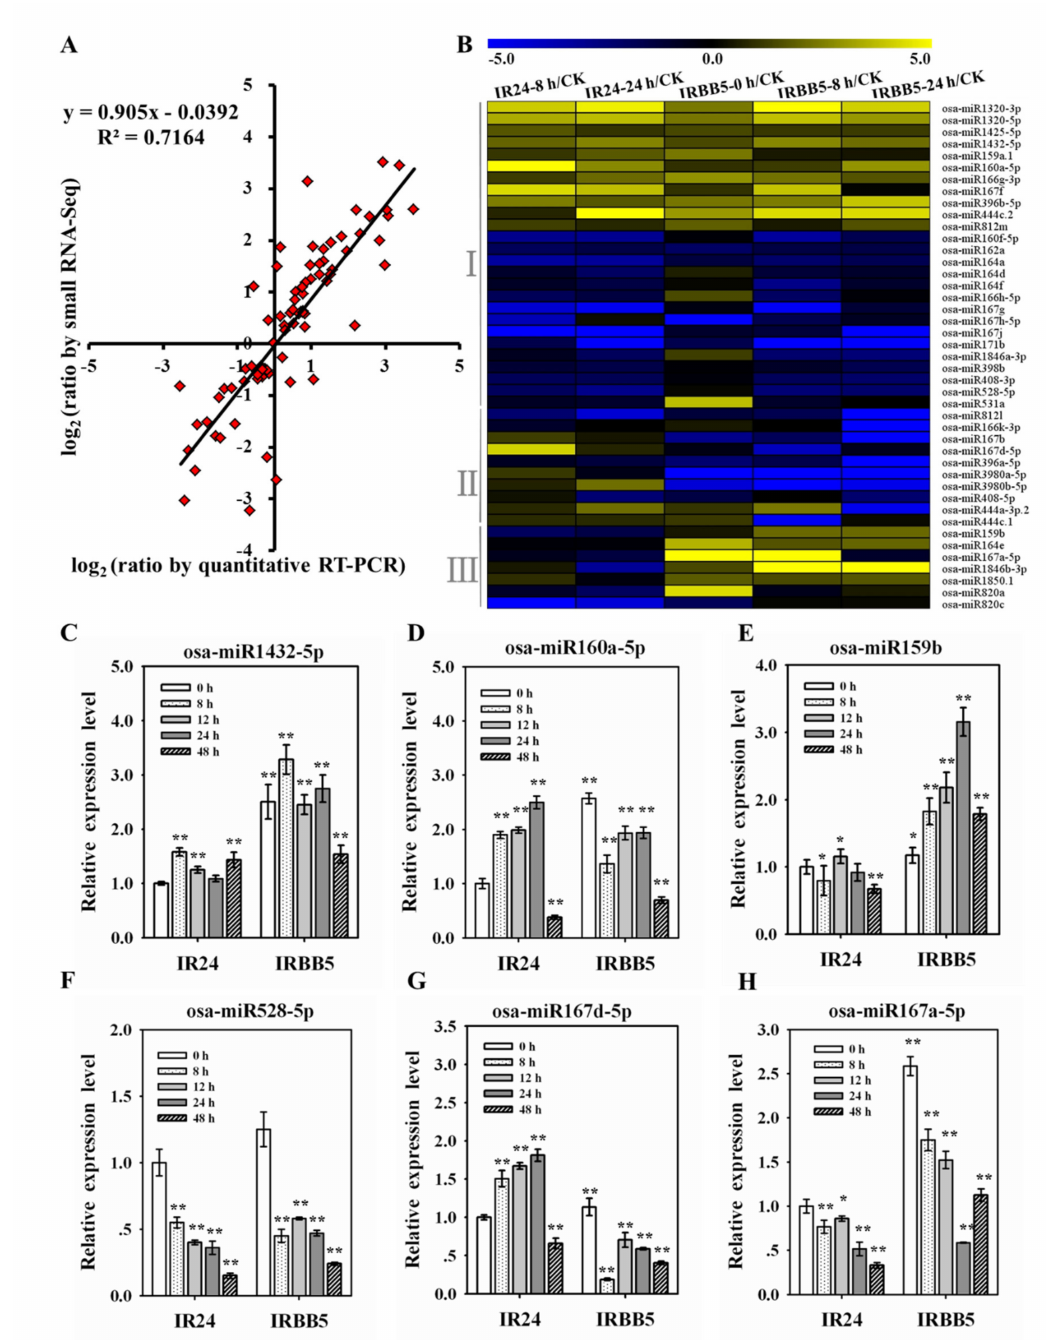
Figure 4. The responsive expression changes of miRNAs after Xoo infection. ( A ) The correlation analysis of miRNA expression level between small RNA sequencing and qRT-PCR experiments. ( B ) Heat map of the documented miRNAs with | log 2 (fold change ratio) | ≥ 1.5 across Xoo infection. Yellow and blue colors represent up-regulated and down-regulated expression level, respectively. CK represents IR24-0 h. ( C and F ) The expression profile of basal immunity regulators, osa-miR1432-5p and osa-miR528-5p, in response to the Xoo strain. ( D and G ) The expression profile of negative immunity regulators, osa-miR160a-5p and osa-miR167d-5p, in response to the Xoo strain. ( E and H ) The expression profile of positive immunity regulators, osa-miR159b and osa-miR167a-5p, in response to the Xoo strain. The miRNA expression levels in all samples were quantified relative to IR24-0 h. Bars represent mean ± standard deviation ( n = 3 independent biological replicates). Asterisks indicate a statistically significant di ff erence (student t -test, ** p < 0.01, * p <